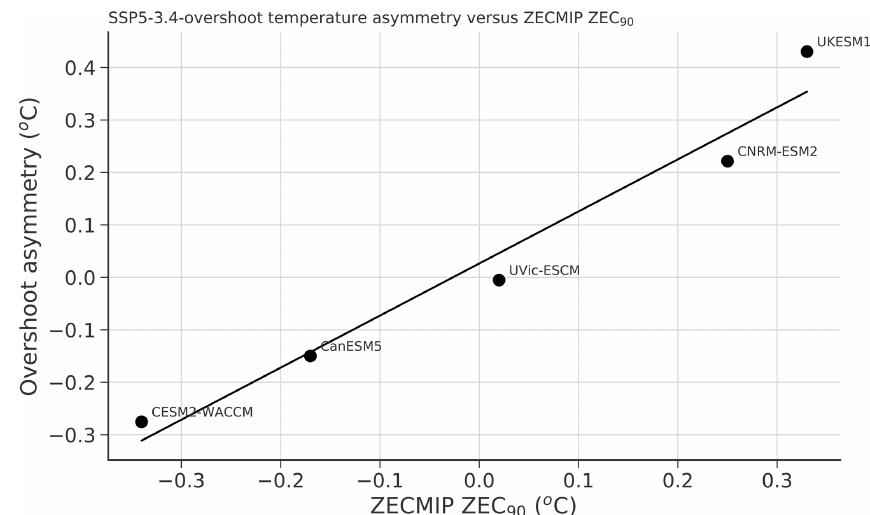
Figure 4. Comparison of the projected overshoot asymmetry in the temperature to cumulative emissions curve for each model for the SSP5- 3.4-overshoot scenario against the zero emissions commitment (ZEC). Overshoot asymmetry is calculated as the temperature difference at a given level of cumulative CO 2 emissions between the descending (negative CO 2 emissions) period and the ascending (positive CO 2 emissions) period. Here we evaluate this for the two 20-year periods centered at the point of 200PgC less than peak cumulative emissions for each model. ZEC values shown are the published values of 90-year zero emissions commitment (ZEC 90 ) from MacDougall et al.